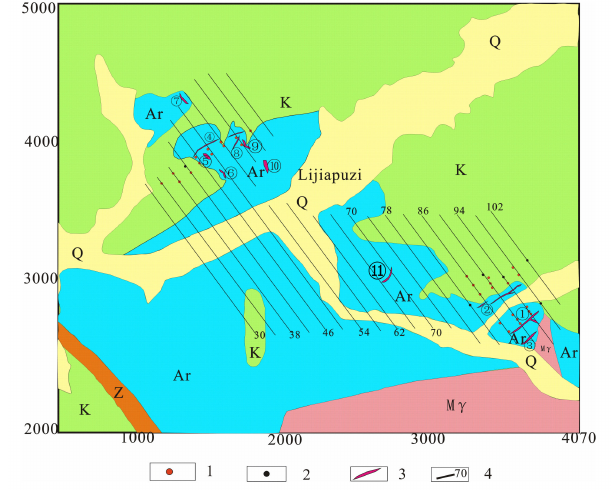
Figure 2. Geological map of Lijiapuzi Nb-Ta deposit. Lithology is the same as Figure 1B. 1- mineralization borehole; 2-non-mineralization borehole; 3-pegmatite ore bodies; 4-sections. The detailed exploration of the Lijiapuzi deposit began in 2008 and finished in 2018 [28]. A total of 11 Nb-Ta bearing pegmatites were explored, with an average of 0.0045%Nb 2 O 5 and 0.0312%Ta 2 O 5 (Table 1). Generally the NE-trending pegmatites are longer but thinner, echelon arranged with relatively regular shape such as the vein-type, have large extension depth and weak or no differentiation. The NW-trending pegmatites are shorter but thicker, and usually occur near the surface with small extension depth and relatively irregular shapes such as lenticular and well-differentiated [27]. All the pegmatites are localized in Archean metamorphic rocks. Note that No.1, No.2 and No.9 pegmatite are composed of both the NE-trending and NW-trending sub-fractures, and the pegmatite dikes occur as a whole, indicating that the pegmatite-controlling fractures were formed contemporarily and probably conjugated. Table 1. The general characteristics of Nb-Ta bearing pegmatites in Lijiapuzi deposit (Adapted from ref.